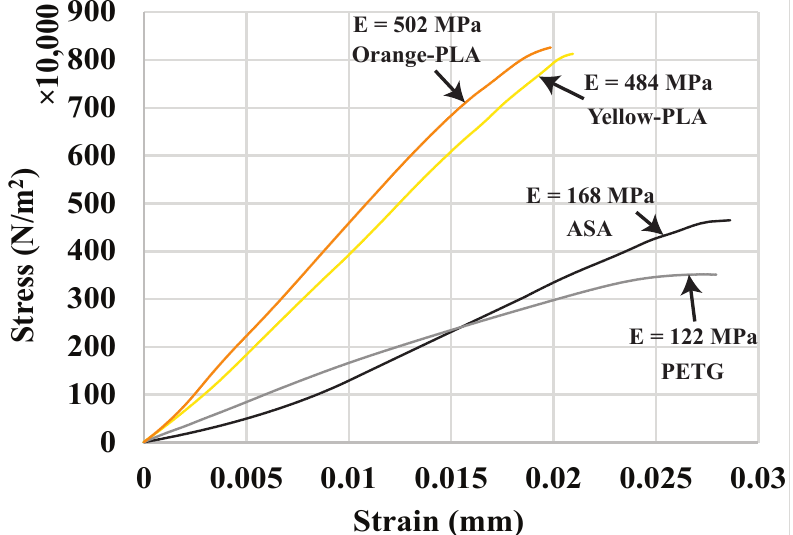
Figure 11. Tensile test curve for single-material